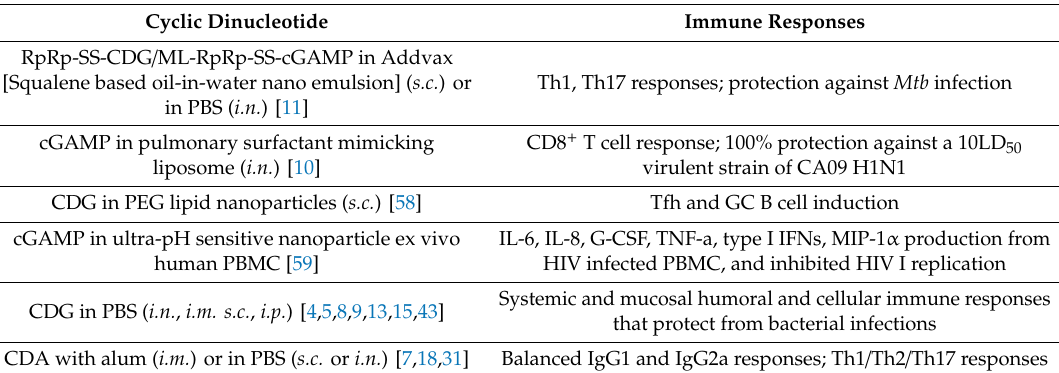
Table 2. Cyclic dinucleotide as vaccine